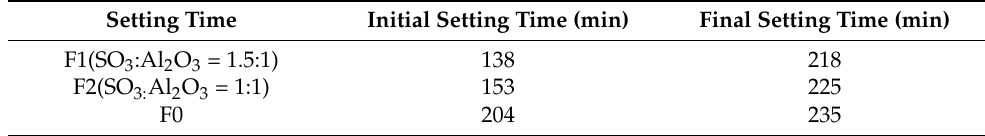
Table 4. Mortar fluidity of specimens.